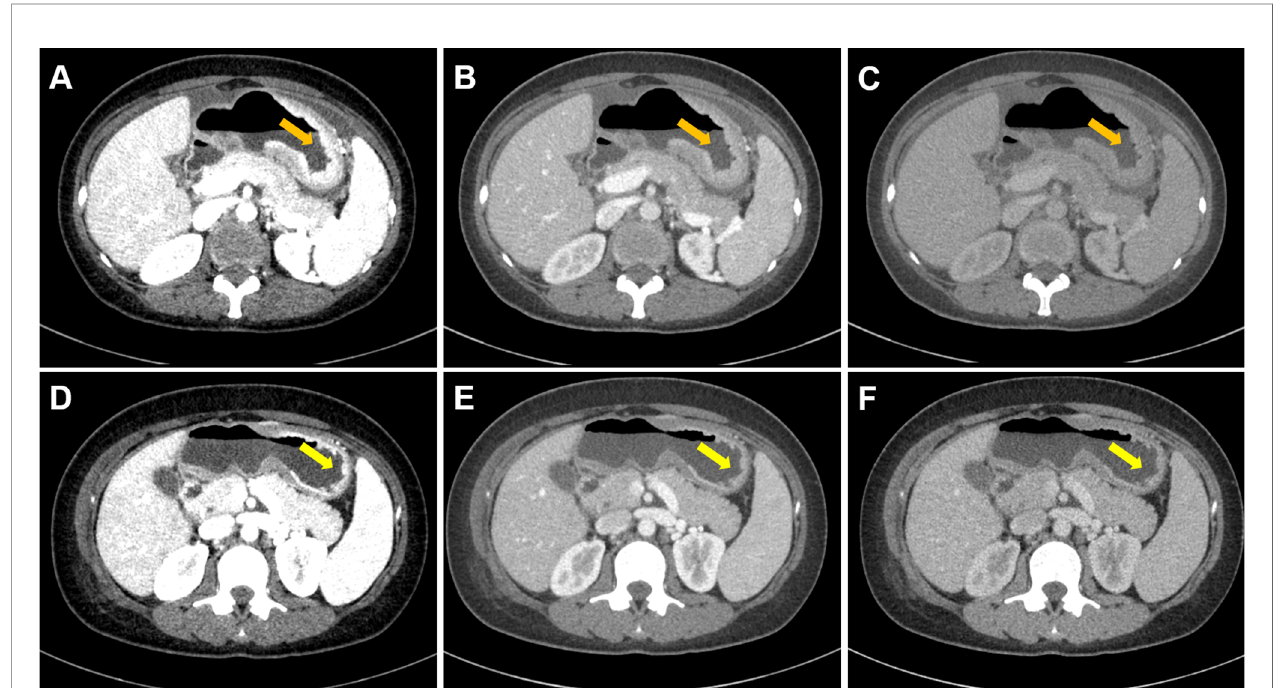
FIGURE 1 | Case 1. Portal phase DECT images of a 34-year-old female with GC patient who responded to chemotherapy. (A – C) Diffuse thickened gastric wall was seen at the gastric body (arrow). (D – F) Slightly thickened gastric wall was seen at the gastric body, and the lesion was signi fi cantly regressed (arrow). (A – C) were monochromatic images of 40, 70, and 100 keV before chemotherapy, respectively. (D – F) were monochromatic images of 40, 70, and 100 keV after chemotherapy,